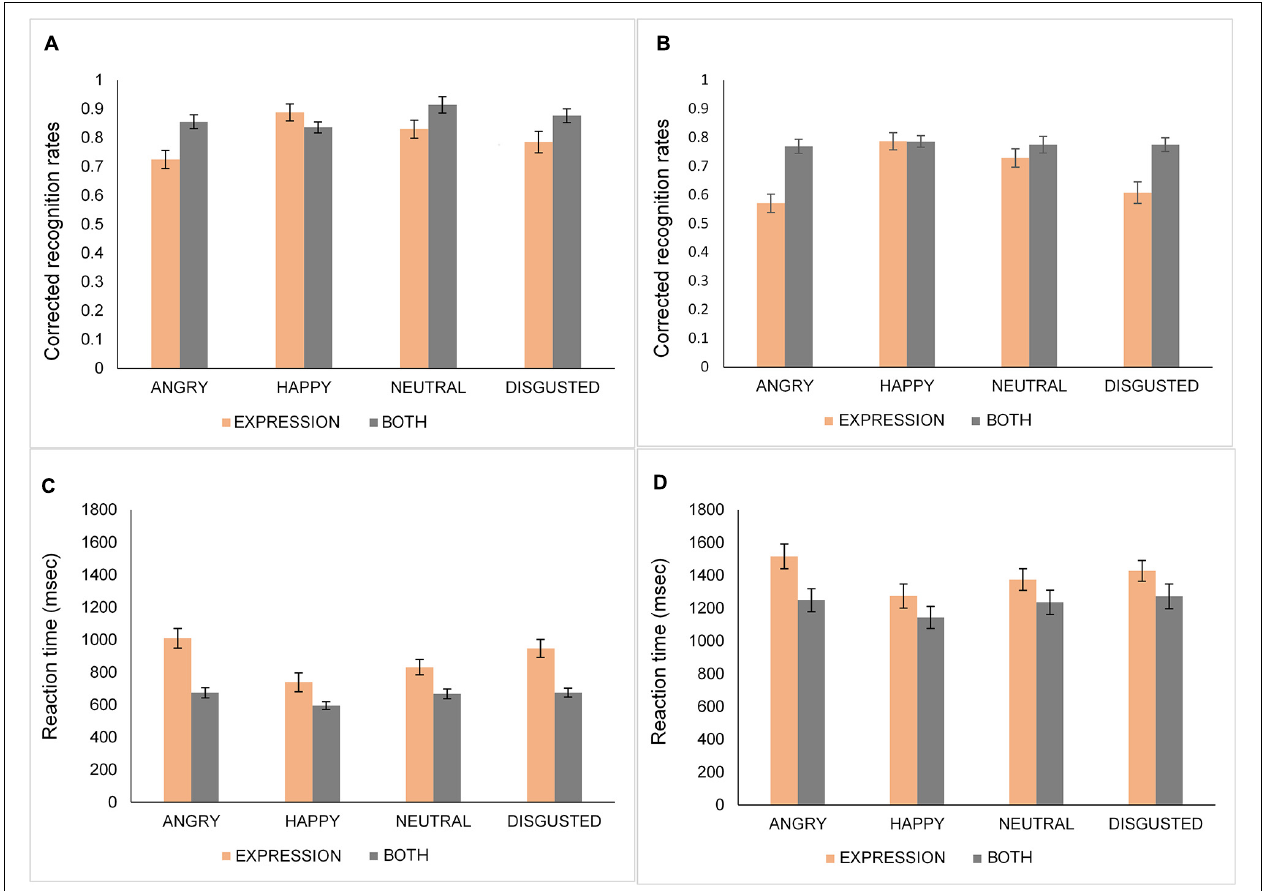
FIGURE 3 | Corrected recognition rates (proportion of hits minus false alarms) and response times of younger (A,C) and older (B,D) adults for angry, happy, neutral, and disgusted faces in the identity, expression, and both conditions. Error bars denote standard error.